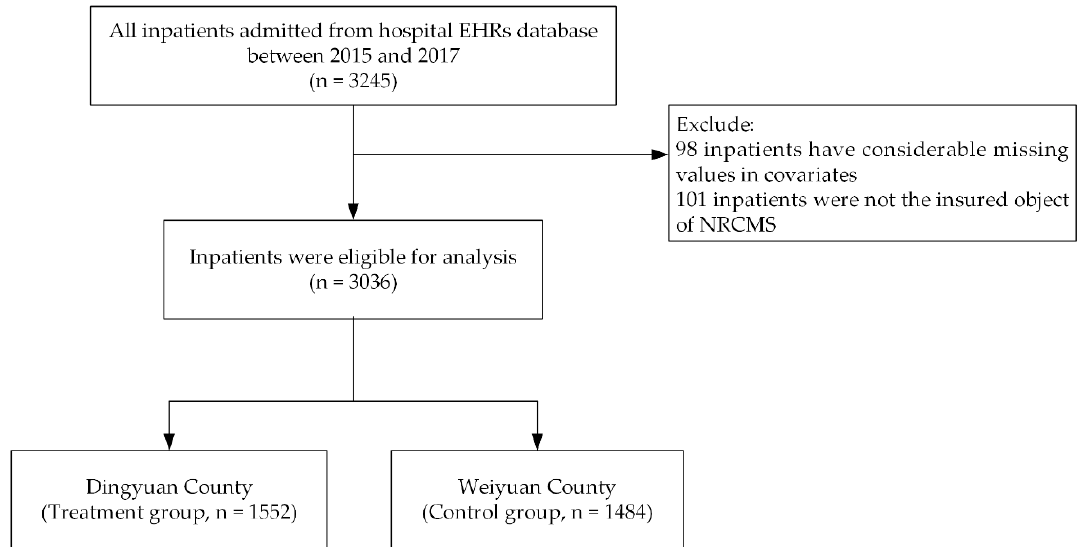
Figure 1. Study design and flow chart of the inpatients selection for new rural cooperative medical scheme (NRCMS) and the classify of those inpatients from hospital electronic health records (EHRs) database in two counties for propensity score matching (PSM).